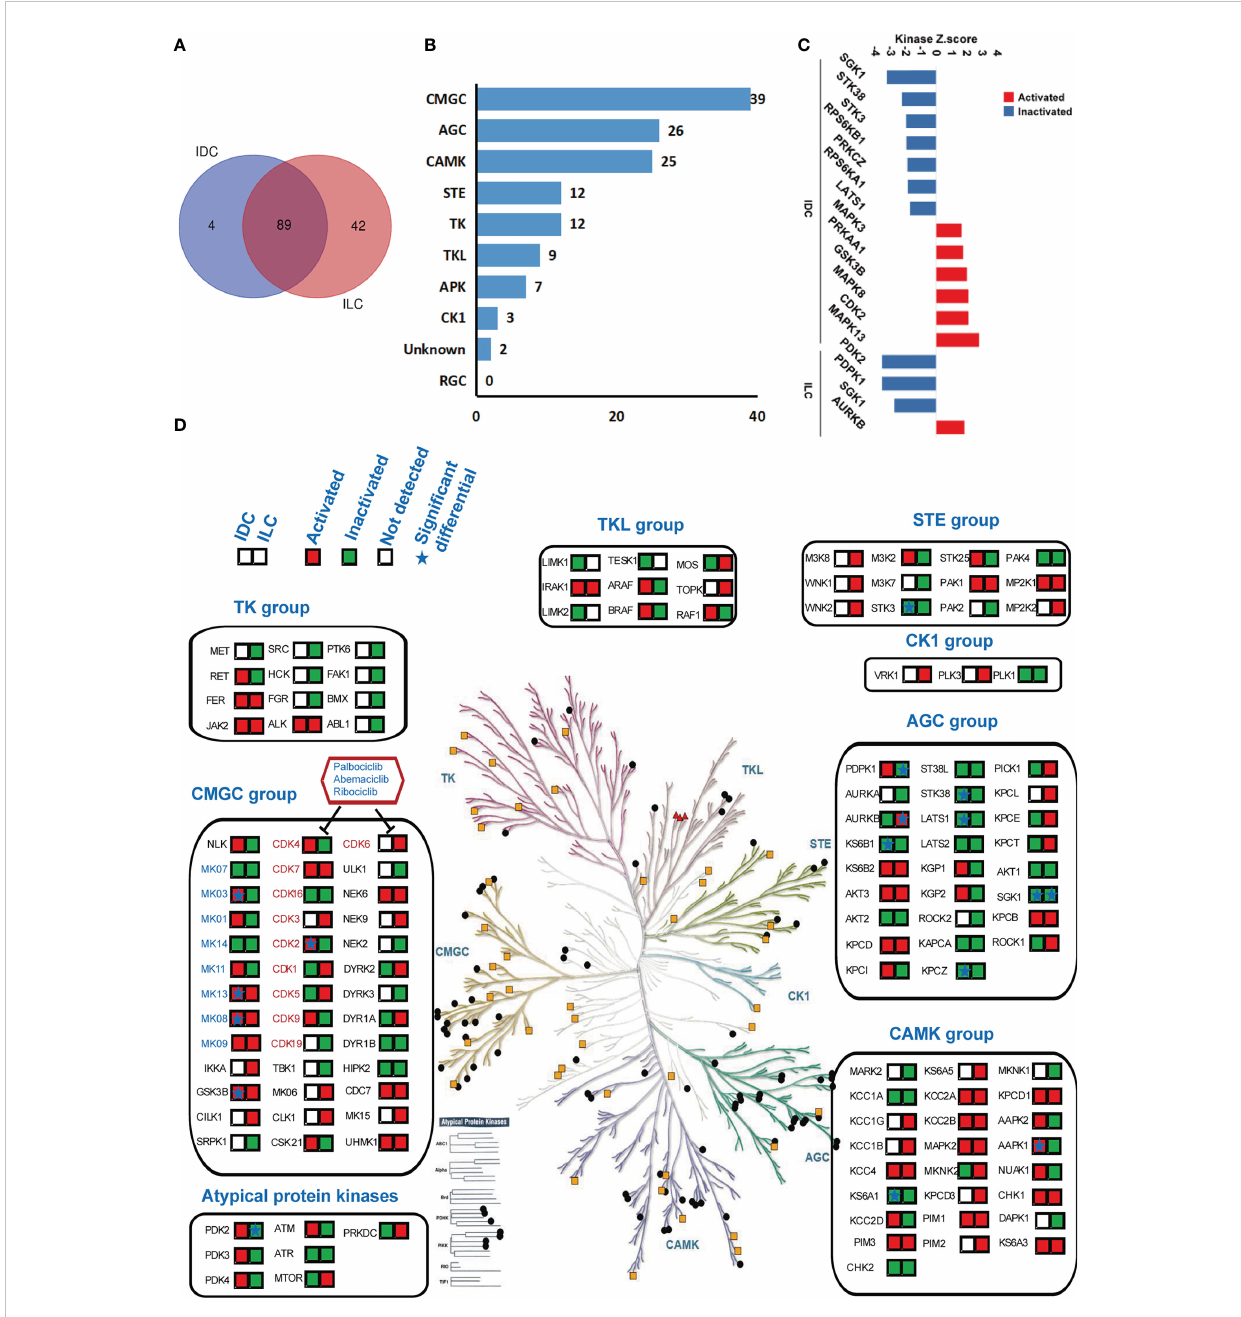
FIGURE 4 Kinase regulation in luminal A breast cancer by KSEA analysis. (A) Venn diagrams of identi fi ed kinases from IDCs and ILCs. Blue: IDCs; red: ILCs. (B) The distribution of 135 identi fi ed kinases in each group of human kinases. (C) Kinase regulation characterization in IDC and ILC. Kinases with a P- value < 0.05 based on the KSEA algorithm are shown. These kinases are predicted to be activated and inactivated in cancer tissue. (D) Compendium of the kinome detected in IDC and ILC under standard conditions. The colored panes with red or green showed the identi fi ed kinases in IDC and ILC. Red means the kinase is activated while green means the kinase is inactivated. The star in the panes means the difference of kinase is signi fi cant between IDC and